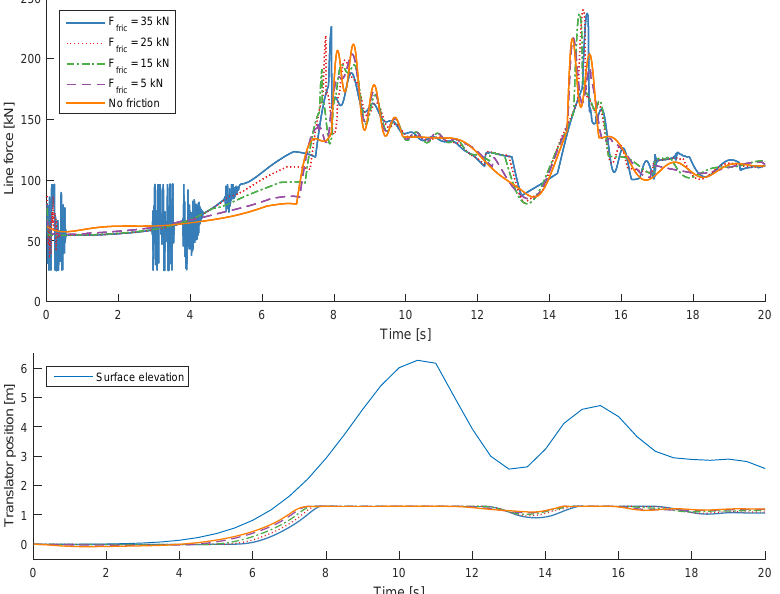
Figure 10. The force in the connection line and the translator position when the WEC is impacted by a tsunami event. Five levels of friction are